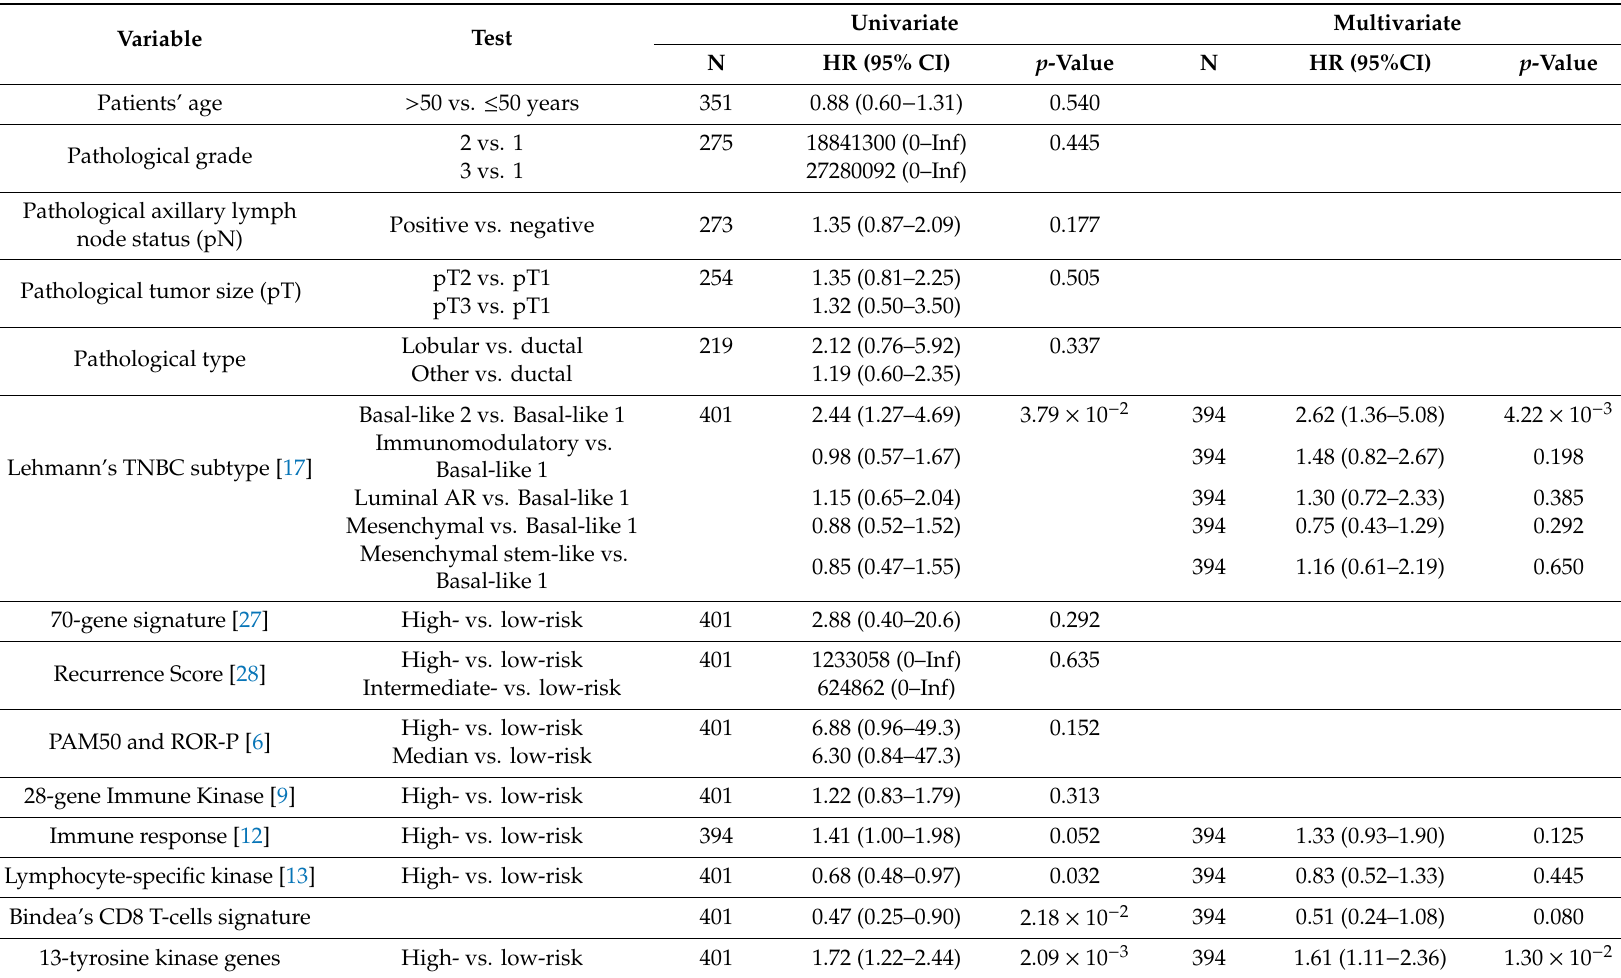
Table 3. Uni- and multivariate prognostic analyses for DFS in the validation